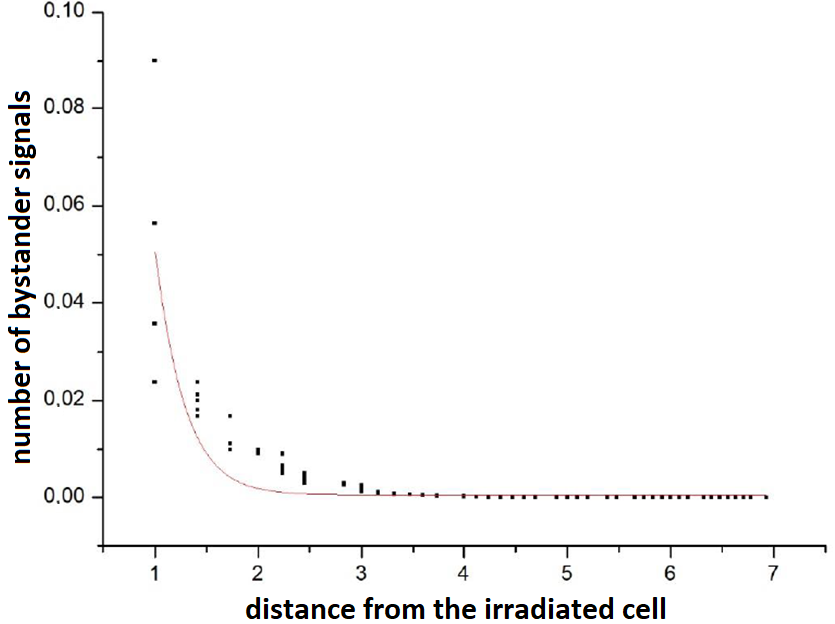
Figure 3. The number (as fraction) of signals of the bystander effect in the function of the distance from the irradiated cell (black points), to which the Poisson distribution was fitted (red curve, 𝑅 2 = 0.67) [26].